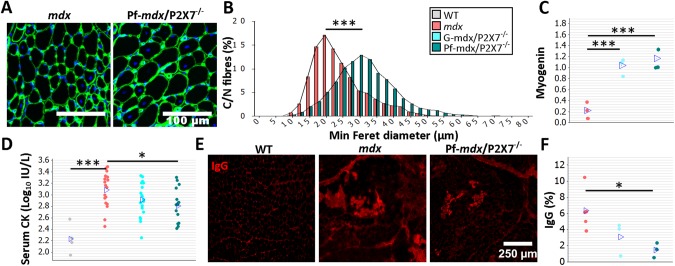
P2RX7 ablation reduces mdx mouse muscle pathology.The color-coding legend applies to all graphs in the figure. (A) Collagen type-IV (green) and nuclei (blue) immunofluorescence with an accompanying frequency histogram (B) of the minimum Feret diameter of C/N fibers from 4-wk-old mdx and Pf-mdx/P2X7−/− mice showing the right shift in TA muscle fiber size corresponding with the greater average Feret diameter of Pf-mdx/P2X7−/− fibers (t-test, t = 6.99, df = 6, p < 0.001). (C) Elevated myogenin levels (average Western blot values) in both Pf-mdx/P2X7−/− and G-mdx/P2X7−/− muscle (ANOVA, F = 33.38, df = 2, n = 4, 3, 4, p < 0.001; Tukey’s test, G-mdx/P2X7−/− versus mdx, p < 0.001; G-mdx/P2X7−/− versus Pf-mdx/P2X7−/−, p = 0.516; Pf-mdx/P2X7−/− versus mdx, p < 0.001) and (D) significantly lower average serum CK levels in Pf-mdx/P2X7−/− compared to mdx muscle (Mann-Whitney U test, W = 388, n = 18, 16, p = 0.012; permutation analysis, F = 7.07, p = 0.013; log10 serum CK ANOVA, F = 3.76, df = 2, n = 19, 18, 16, p = 0.030; Tukey’s test, Pf-mdx/P2X7−/− versus mdx, p = 0.025). (E) Example immunofluorescence micrographs of IgG penetration into muscle fibers and (F) chart showing reduced average IgG influx into Pf-mdx/P2X7−/− muscle (ANOVA, F = 5.52, df = 2, n = 3, 5, 3, p = 0.031; Tukey’s test, Pf-mdx/P2X7−/− versus mdx, p = 0.032). *p < 0.05, ***p < 0.001.